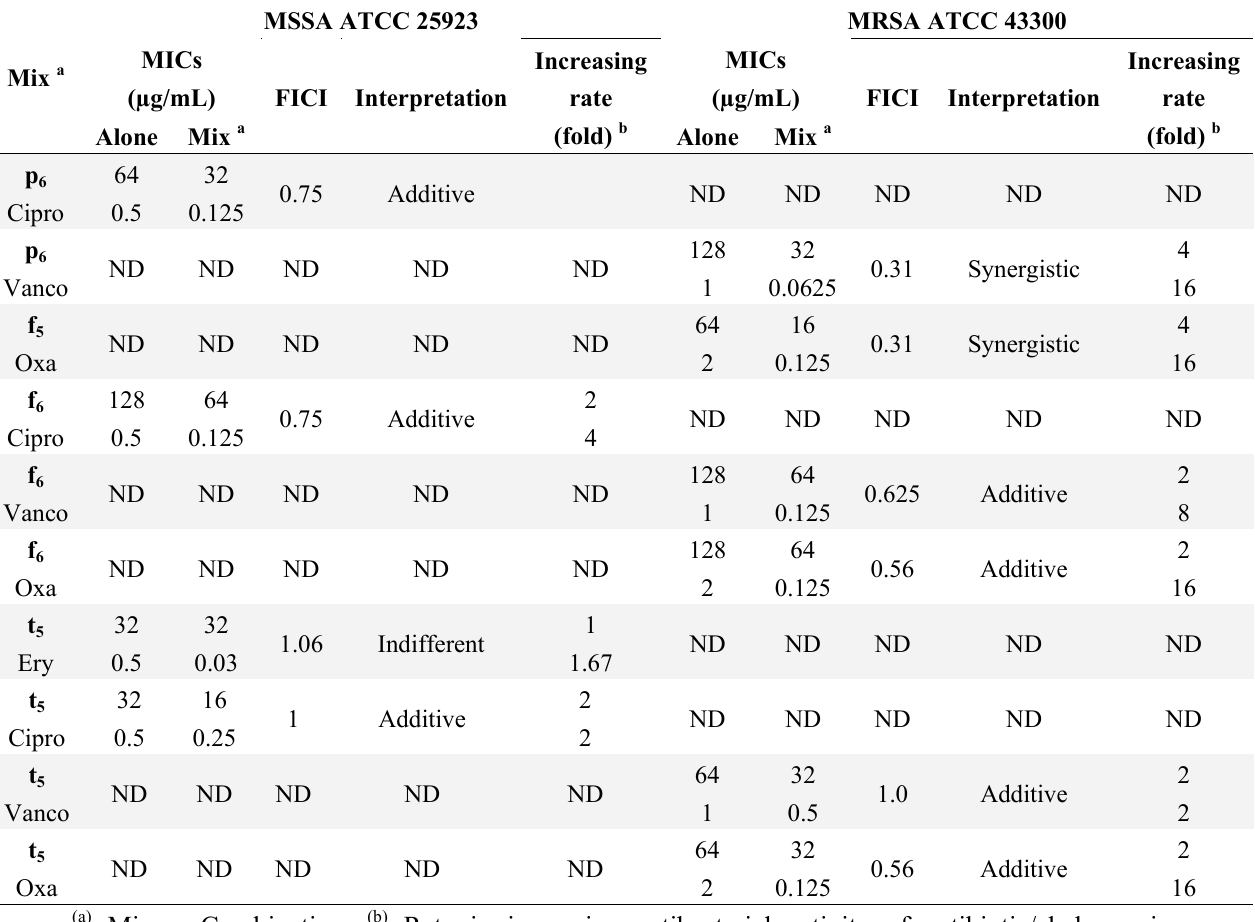
Table 4. Anti-SA and anti-MRSA activity of chalcones in combination with